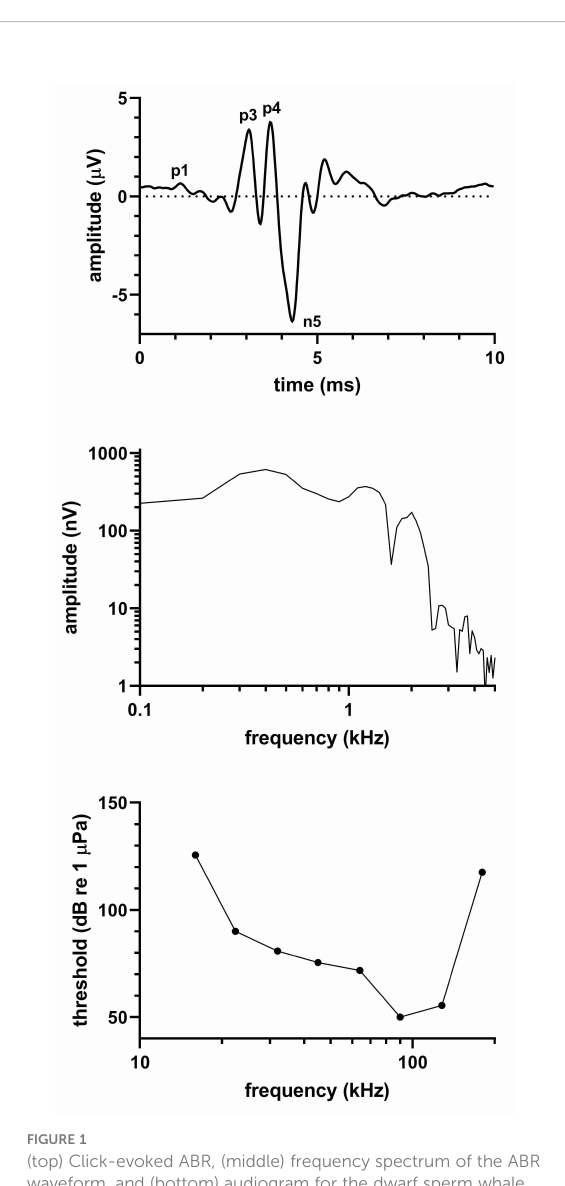
FIGURE 1 (top) Click-evoked ABR, (middle) frequency spectrum of the ABR waveform, and (bottom) audiogram for the dwarf sperm whale. The click-evoked ABR waveform is labeled as previously described (Popov and Supin,